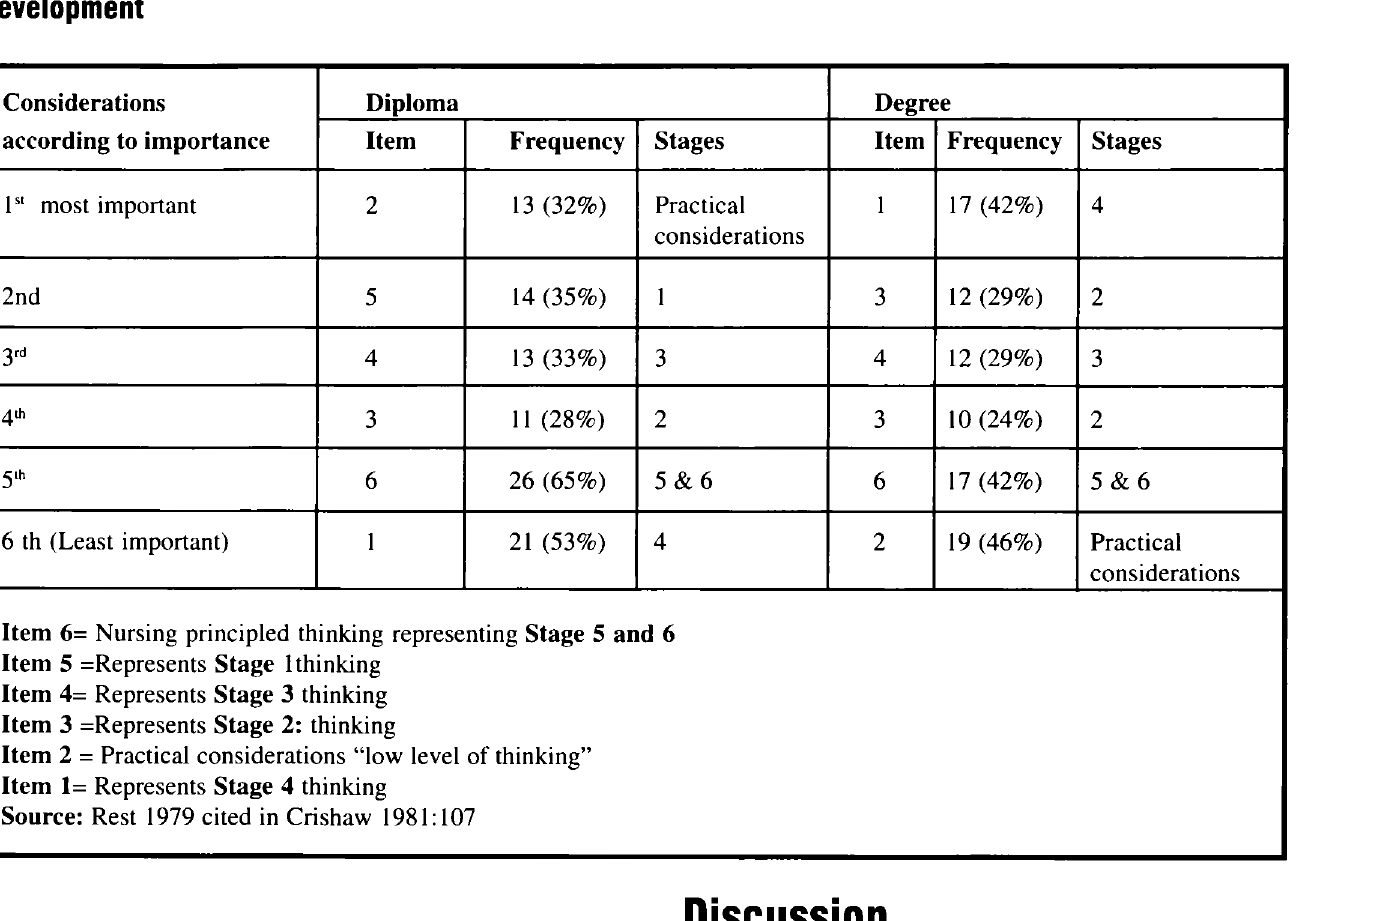
Table 4: Frequency scores of ranked items indicating stage of thinking in moral judgement